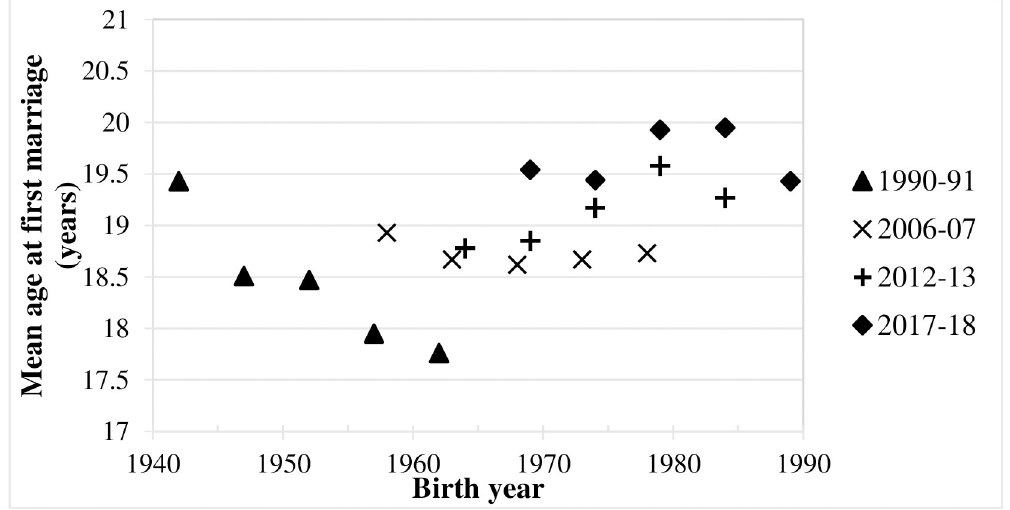
Fig 1. Mean age at first marriage (AFM)) for women born in different years: Four Pakistan Demographic and Health Surveys (PDHSs) (1990–91, 2006–07, 2012–13 and